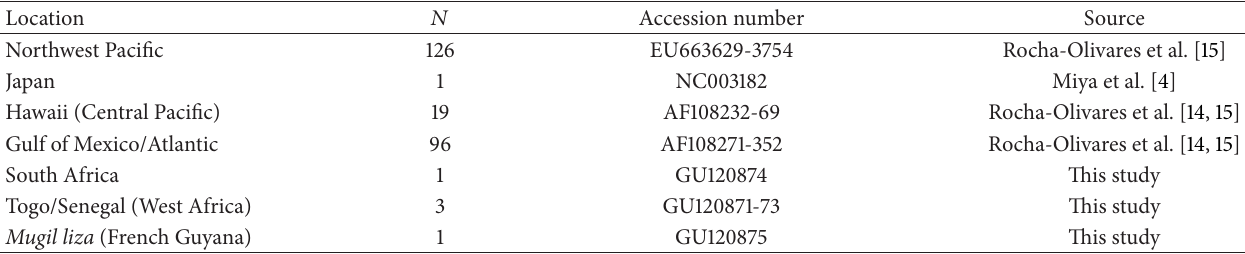
Table 1: Location, number of samples ( 𝑁 ), and the GenBank (http://www.ncbi.nlm.nih.gov/) accession numbers of the mtDNA control region sequences of M. cephalus used in this